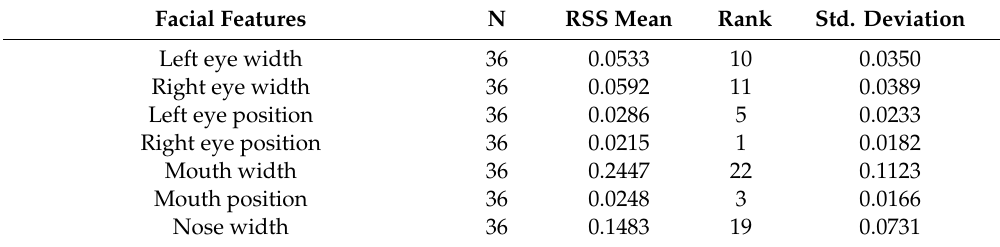
Table 3. The relativity shift score (RSS) means between happy expression and neutral mode of 22 facial features for 36